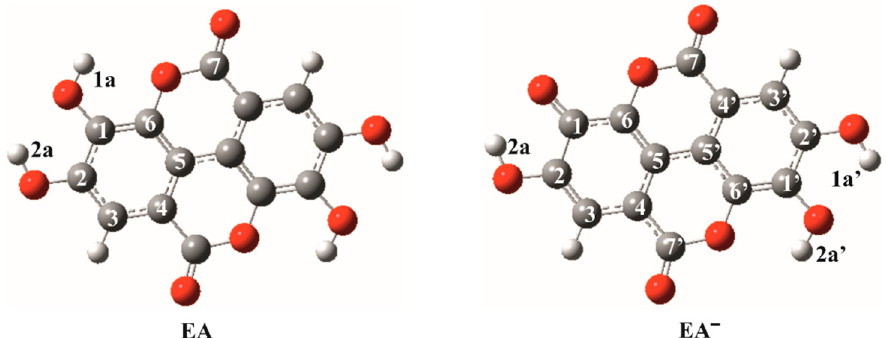
Figure 1. Optimized structures of neutral ellagic acid and its monoanion. Carbon atoms are depicted in gray, oxygen atoms in red, chlorine atoms in green and hydrogen atoms in white color. The atom labeling scheme and color coding are applied throughout the study.